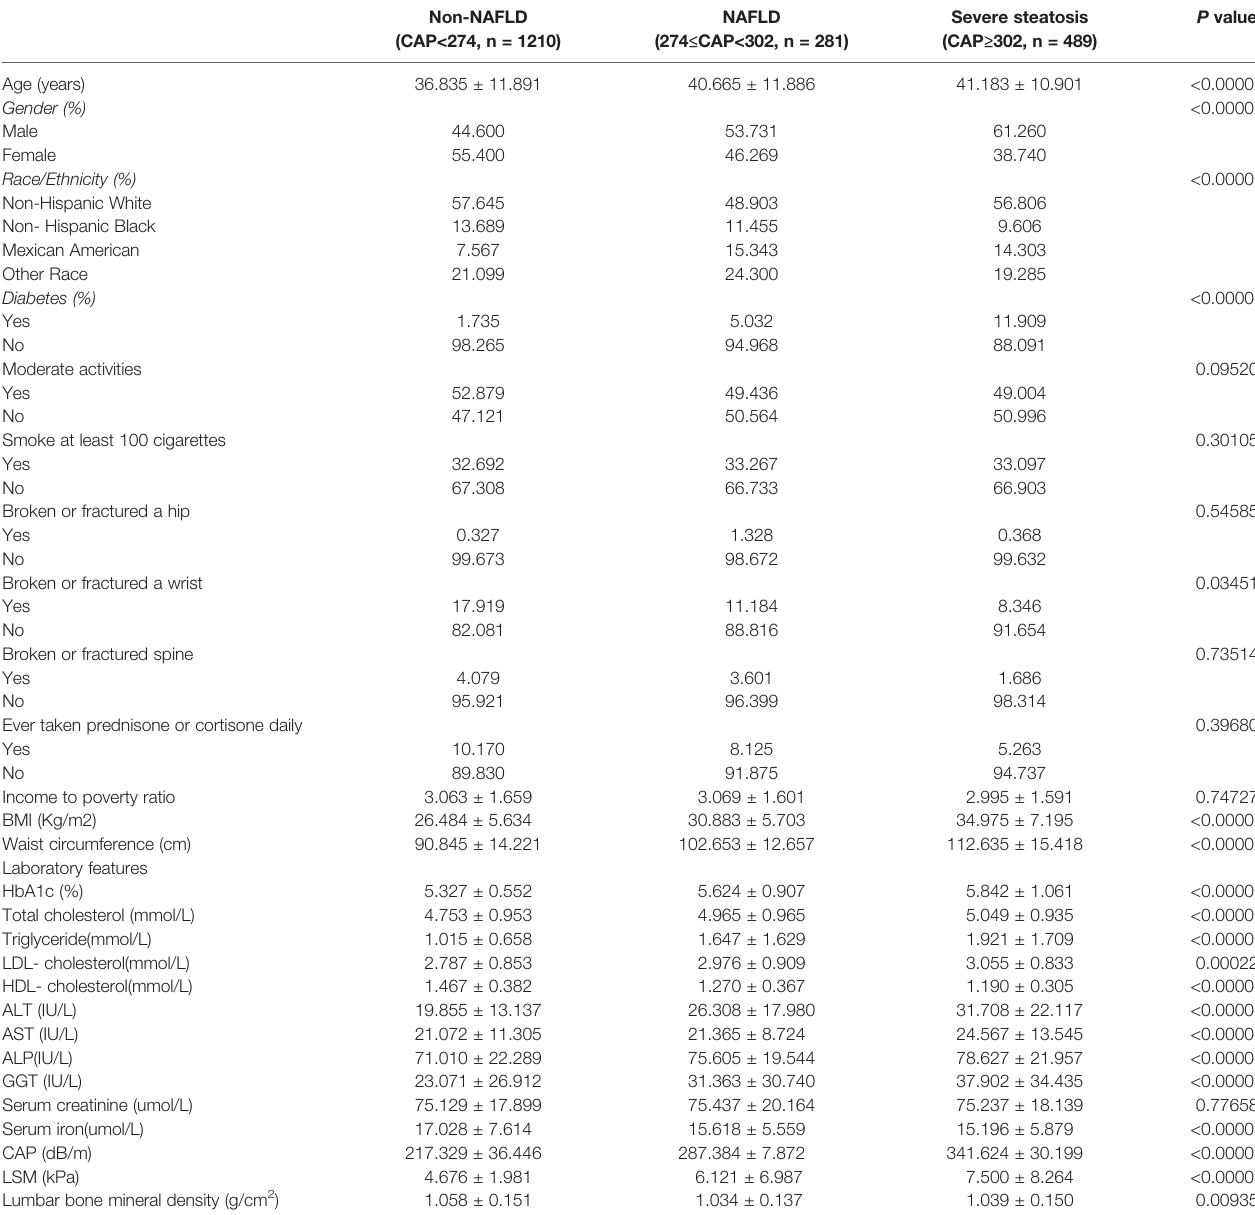
TABLE 1 | Weighted characteristics of the study population based on